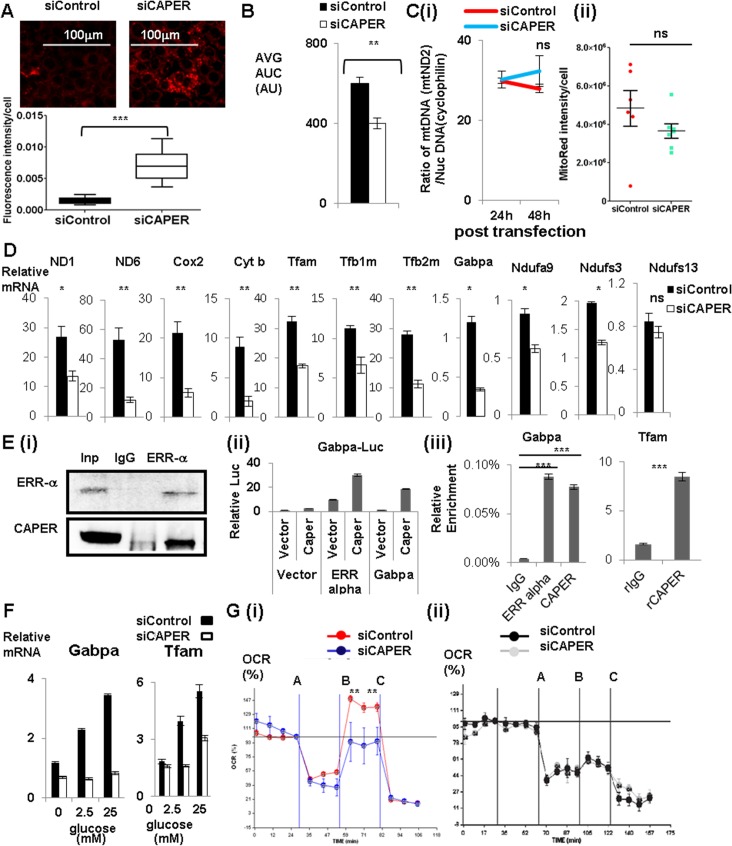
CAPER increases glucose-dependent mitochondrial respiration by regulating glucose-induced mitochondrial transcription via ERR α -Gabpa.A. Fluorescence pictures (upper panel) showing MitoSox (red) stained cells after transfection with either siControl (left panel) or siCAPER (right panel) and their corresponding quantitative graphs (lower panel). Pictures were taken at 24 hours after siRNA transfection. A scale bar is present. Staining intensity was quantified by Image J software and statistical significance was calculated by student’s t-test using GraphPad software. B. A graph presenting the area under the curve (AUC) of basal OCR from cells 24 hours after transfection with either siControl (black) or siCAPER (white) with assay media containing 50mM pyruvate. C. Graphs showing the ratio of mitochondrial DNA copy number (mtND2) to nuclear DNA copy number (cyclophilin) (i) and the intensity of Mitotracker Red (ii). Cells transfected with siCAPER (blue) are compared with siControl (red). Genomic DNAs were isolated from cells harvested at the indicated time after transfection followed by qPCR to quantitate relative ratio of DNA copy numbers by measuring amount of mitochondrial ND2 and nuclear cyclophilin. D. Graphs showing lower mRNA levels of mitochondrial genes and mitochondrial transcription machinery and representative Gabpa target genes encoding ETC complex I in cells transfected with siCAPER (white) than cells with siControl (black). E. (i) Immunoprecipitation assays showing that endogenous CAPER and endogenous ERR α interact with each other. Cleared whole cell extracts in BC180-0.05 (BC buffer containing 180mM KCl with 0.05% of NP-40) from AML 12 cells were subjected to immunoprecipitation with either a rabbit IgG or anti-ERR α antibody. After 4 hours of binding, protein A/G (Santa Cruz) beads were added for another hour. Bound proteins were washed 5 times with BC180-0.1 (BC buffer containing 180mM KCl with 0.1% of NP-40) followed by acid elution using glycine (pH2.5). Elutes were subjected to SDS-PAGE to score the presence of CAPER by Western blot. (ii) Luciferase reporter assays showing that CAPER coactivates ERR αand Gabpa to enhance luciferase reporter activity from the Gabpa promoter. Luciferase assays were performed 48 hours after transfection as described in the Materials and Methods section. (iii) Chromatin immunoprecipitation assay showing that CAPER is present on the ERR α binding sites in Gabpa promoters and the Gabpa binding sites in the Tfam promoter. The procedures were essentially as described in the Materials and Methods. F. qRT-PCR revealed that CAPER and its targets are regulated by glucose in a dose dependent manner. Glucose-dependent induction of target genes were diminished with siCAPER (white) compared to siControl (black). 6 hours after transfection, cells were changed into glucose-free media containing the indicated concentration of glucose for 48 hours. RNAs were extracted and subjected to qRT-PCR analyses as described in the Materials and Methods section. G. (i) A Graph showing real time measurements of OCR of cells treated with either siControl (red) or siCAPER (blue) containing glucose using a XF analyzer in the presence of consecutive treatments with an ATPase inhibitor, oligomycin (A), followed by a protonophore, carbonyl cyanide 4-trifluoromethoxy phenylhydrazone (B), and then lastly by a complex III inhibitor, Antimycin A (C). (ii) A Graph showing real time measurements of OCR of cells treated with either siControl (black) or siCAPER (gray) without glucose using a XF analyzer in the presence of consecutive treatments with an ATPase inhibitor, oligomycin (A), followed by a protonophore, carbonyl cyanide 4-trifluoromethoxy phenylhydrazone (B), and then lastly by a complex III inhibitor, Antimycin A (C).